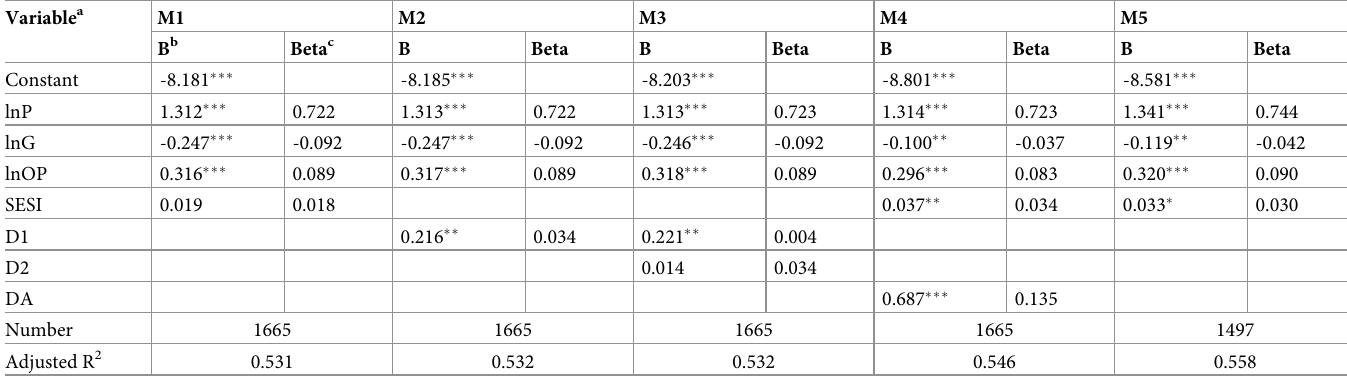
Table 2. Regression results of the gravity